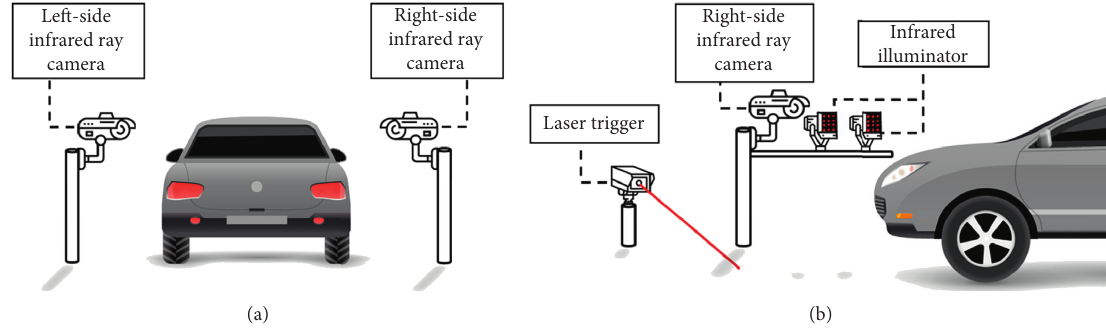
Figure 1: Overview of the image acquisition system for vehicle occupancy detection. (a) Rear view. (b) Side view.